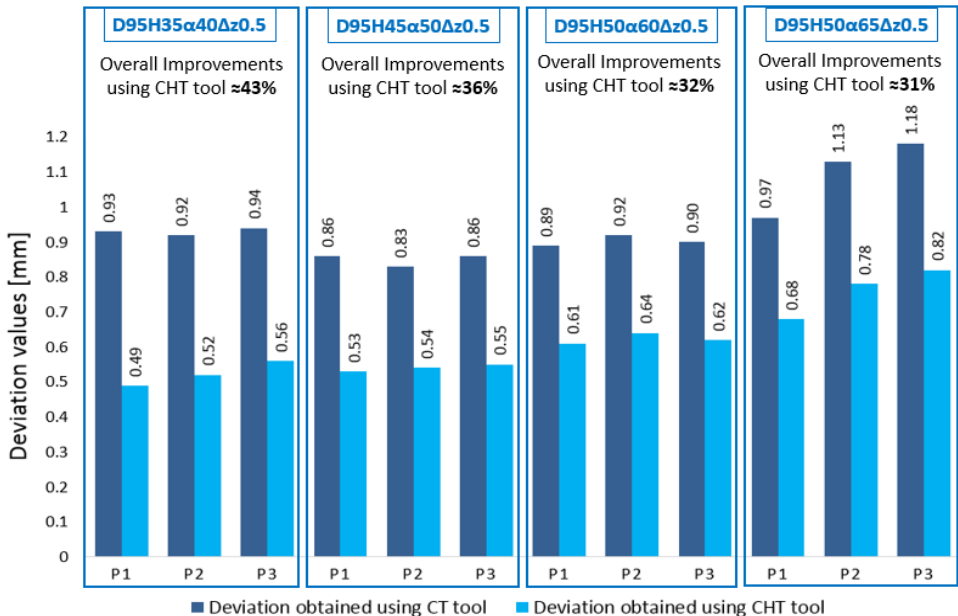
Figure 14. Deviations P1, P2, and P3 of all parts in the preliminary tests, adapted with permission from ref. [5].